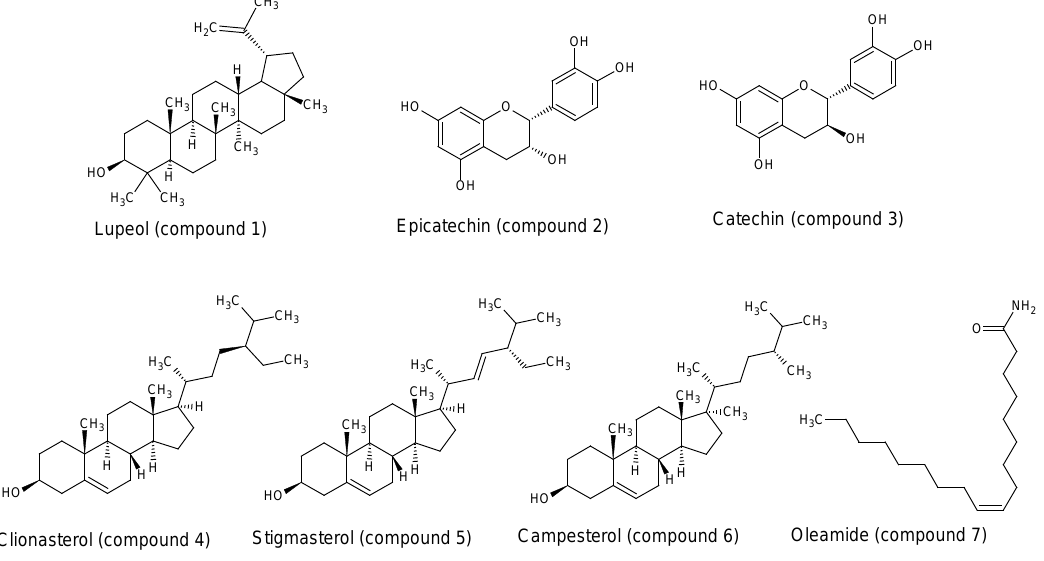
Figure 2. Identified compounds in A. seyal bark.